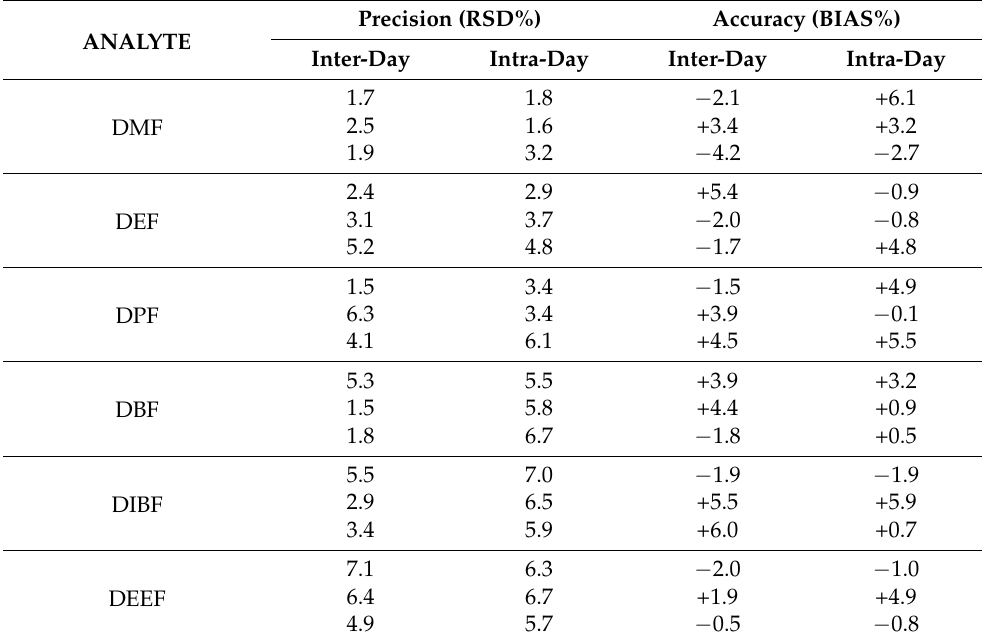
Table 1. Precision and accuracy for the proposed SPE-HPLC-PDA